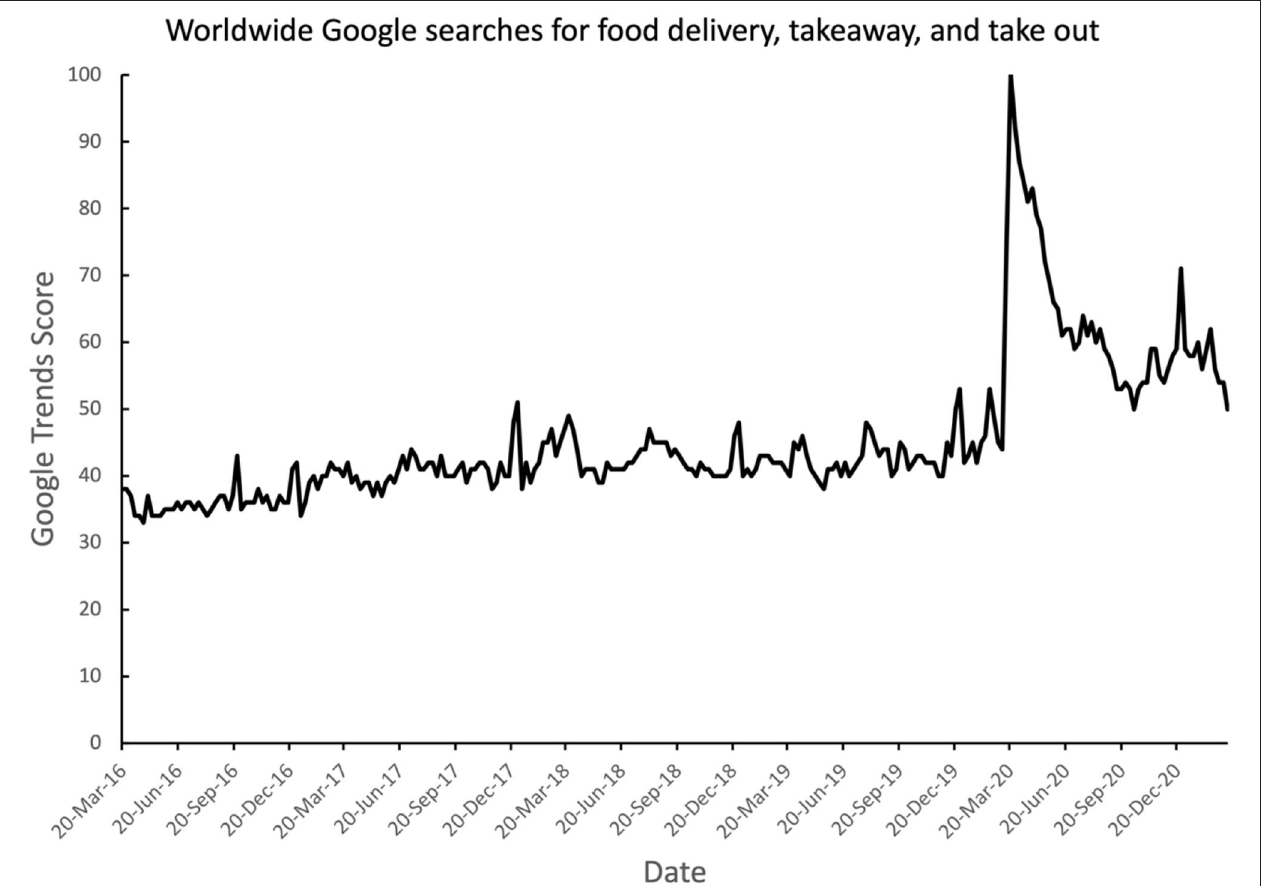
FIGURE 2 | Google Trends data highlighting the major increase in combined online searches for “food delivery,” “takeaway,” “take away,” “takeout,” and “take out” in spring 2020, shortly after the global Covid pandemic lockdowns took hold around the globe. Data are scaled such that a score of 100 represents the peak number of